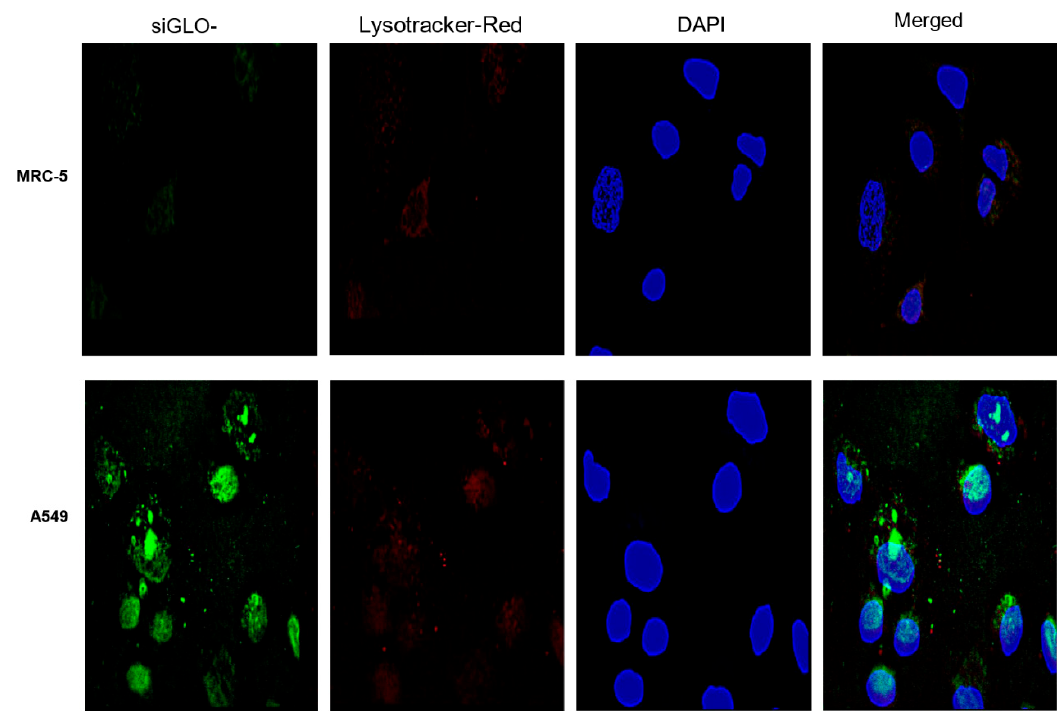
Figure 2. Intracellular delivery of siGLO-FAM loaded into MUC 1-aptamer functionalized nanoparticles. Upper panels show the nanoparticles in MRC-5 fibroblast cells while the lower panels show the delivery of nanoparticles to MUC 1 expressing A549 cells.